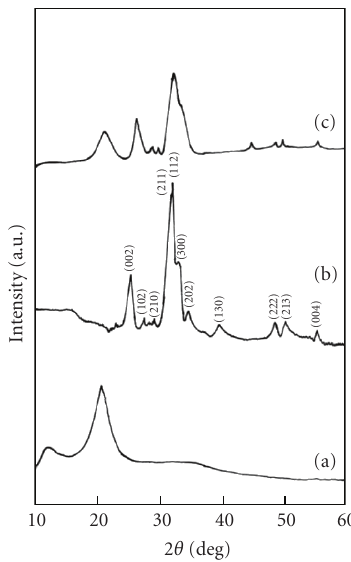
Figure 1: X-ray di ff raction patters of (a) CSP, (b) HAp, and (c) HAp/CSP